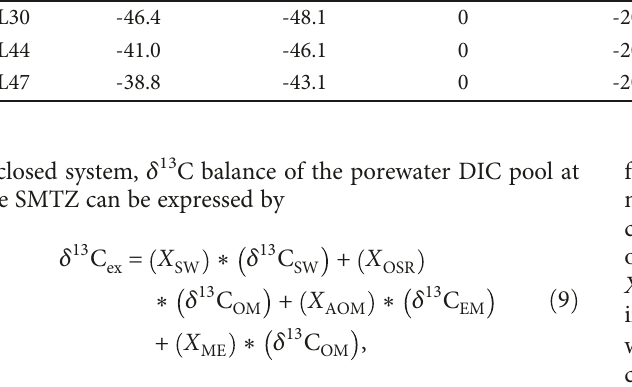
Figure 7: Plots of DIC vs. DIC × δ 13 DIC . The δ 13 C were calculated using the linear regression of DIC × δ 13 C vs. DIC for CL30 (a), CL44 (b), ex and CL47 (c). Table 5: Fractions of DIC from di ff erent sources contributed to the total DIC pool and δ 13 C values from di ff erent sources. δ 13 C ( ‰ Core SMTZ ID